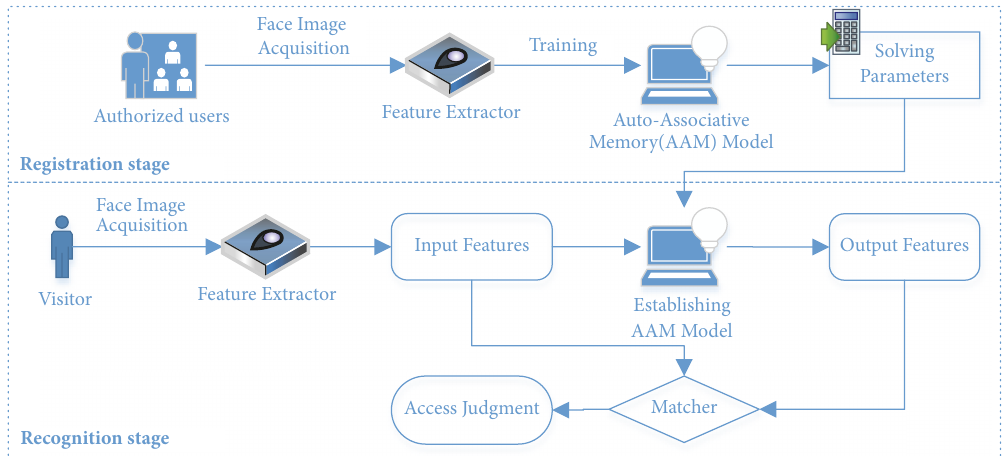
Figure 1: Flowcharts of the face recognition method by AAM based on